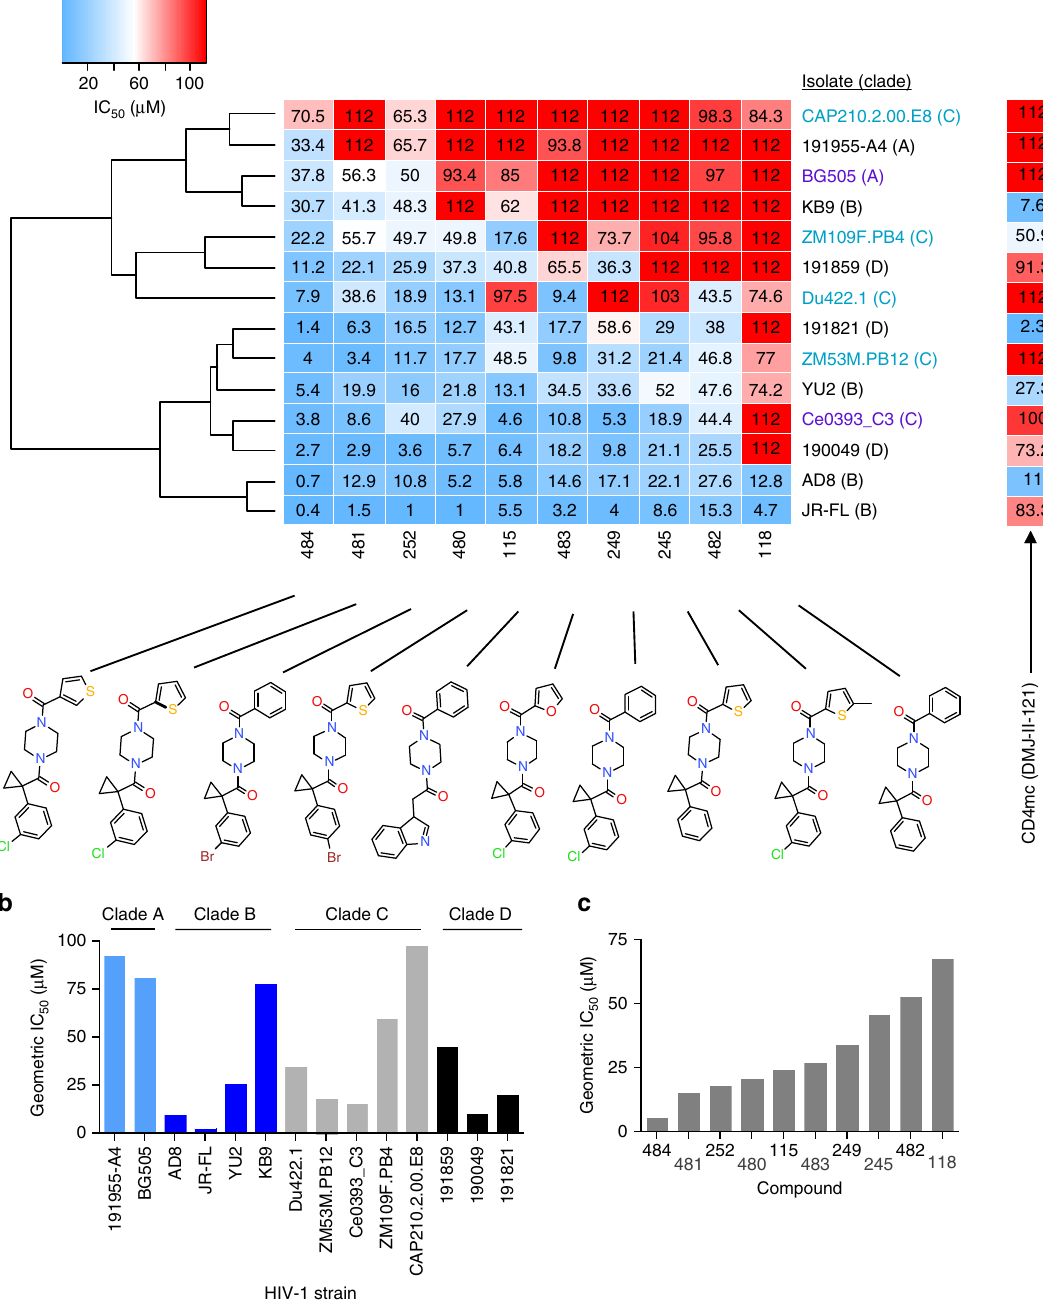
Fig. 1 Chemical probes of HIV-1 Env function. a A panel of chemical probes was developed and tested for inhibition of a diverse set of HIV-1 strains from different clades. The average IC 50 values were calculated from those obtained in two or three independent experiments. The IC 50 of each compound for each virus strain is plotted on a heat map; the compounds are ordered according to the geometric mean IC 50 of each compound against the panel of viruses and the viruses are clustered according to the combination of IC 50 s of the set of compounds against a speci fi c strain. Transmitted/founder, acute/early, and primary isolates are shown with purple, light blue, and black letters, respectively. Under the conditions tested, variation of up to two orders of magnitude in sensitivity to the different compounds was observed across different HIV-1 isolates. b The geometric mean IC 50 of all compounds against each speci fi ed HIV-1 strain. c The geometric mean IC 50 of each speci fi ed compound against the panel of viruses NATURE COMMUNICATIONS | 8:1049 | DOI: 10.1038/s41467-017-01119-w |